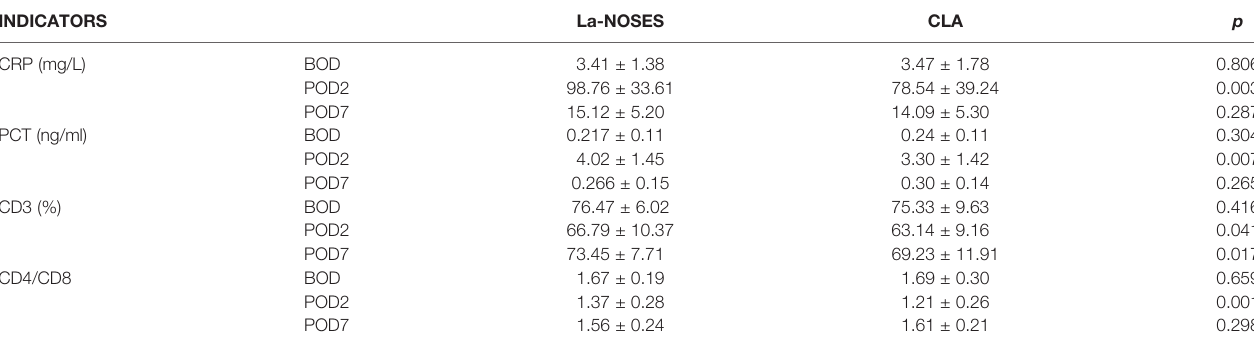
TABLE 3 | The in fl ammatory and immune indicators results.